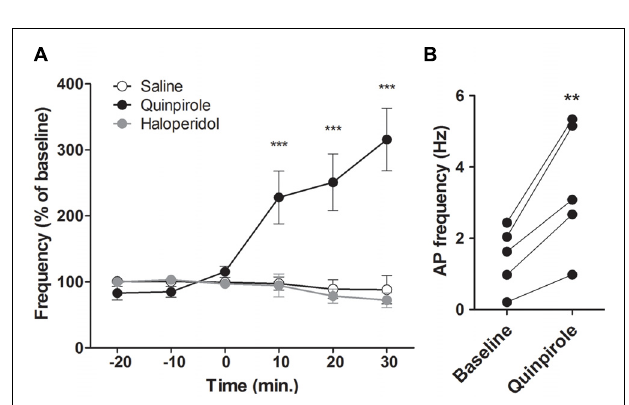
FIGURE 4 | D 2 modulation of M1 neuronal activity. (A) Effect of a peripheral injection of D 2 agonist quinpirole ( n = 5, black) or D2 antagonist haloperidol ( n = 6, grey) or NaCl 0.9 % ( n = 5, white) on putative pyramidal neurons firing frequency. (B) Individual responses of putative pyramidal neurons to the D2 agonist. ** p < 0.01; *** p < 0.001.